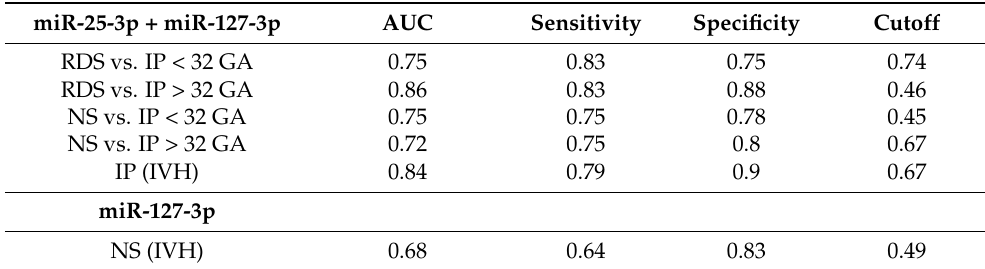
Table 5. Predictive values of miR-25-3p and miR-127-3p in newborns with perinatal outcomes according to gestational age.